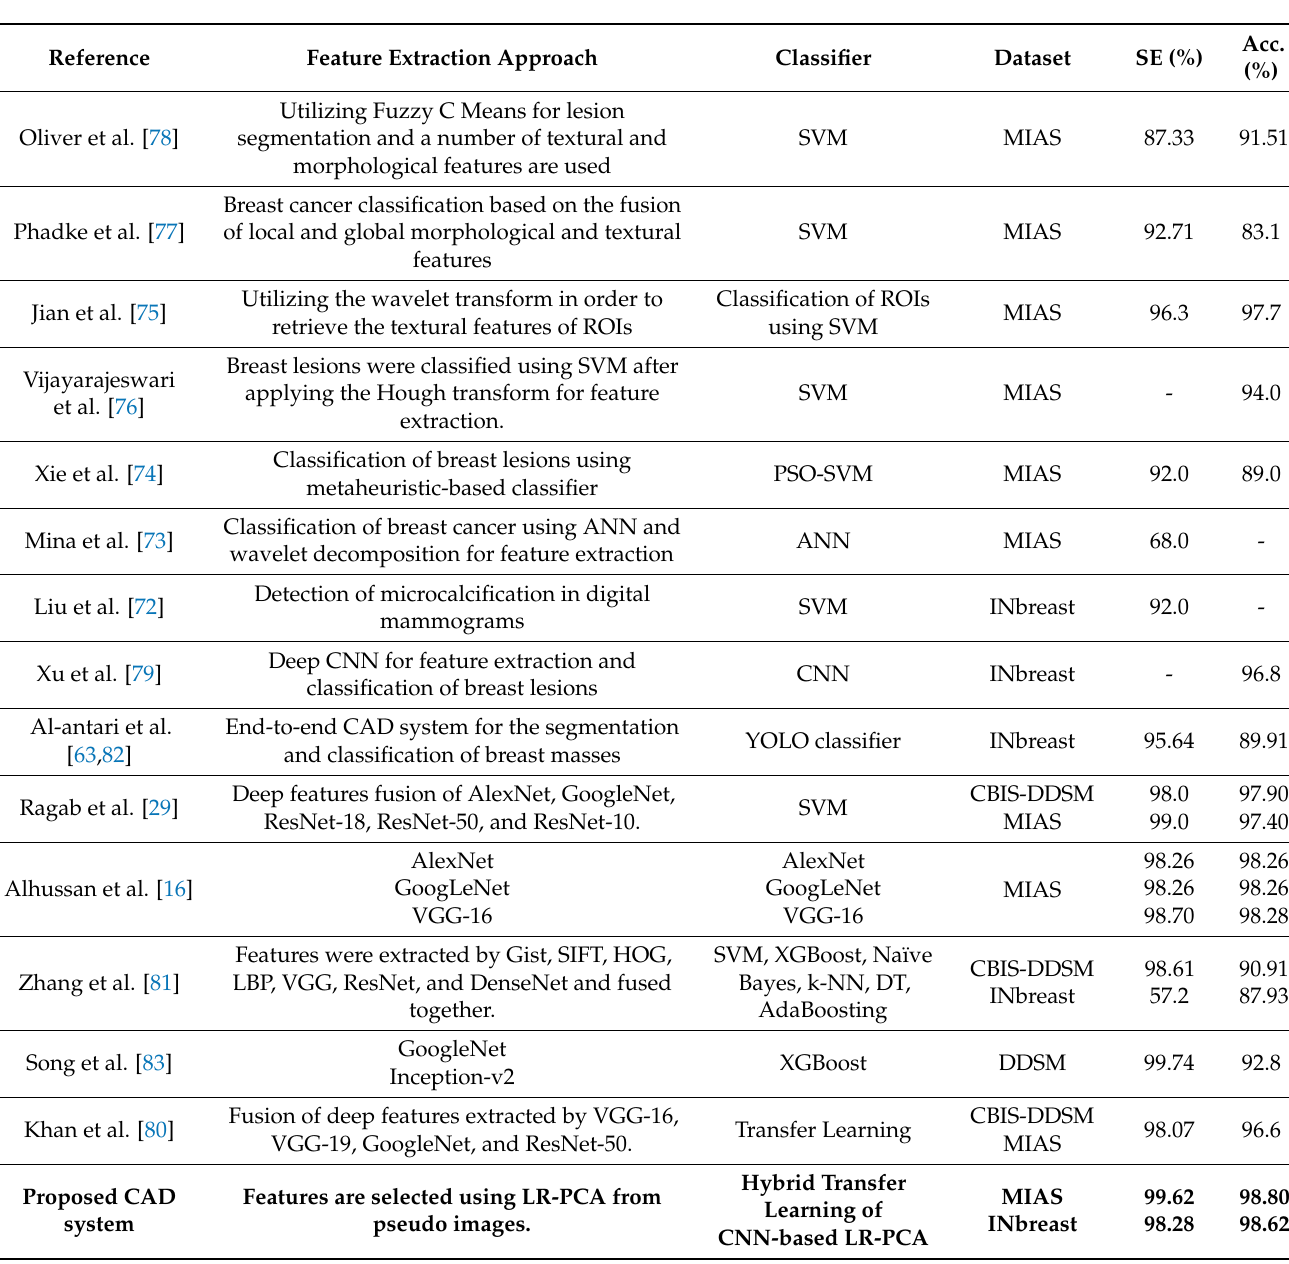
Table 4. Evaluation comparison results of the proposed CAD system against the state-of the-art breast cancer classification